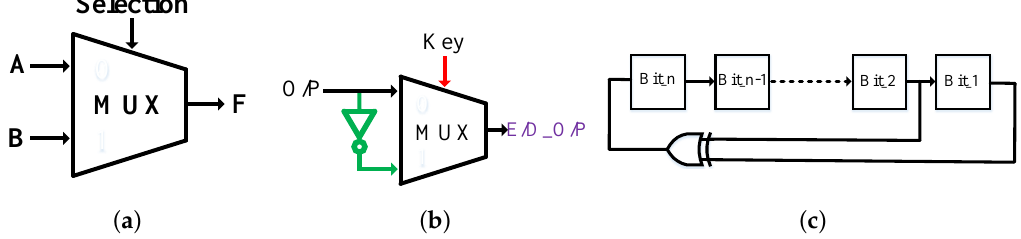
Figure 2. ( a ) Simple multiplexer. ( b ) Multiplexer to encrypt or decrypt the output bit. ( c ) Control the output value by the key